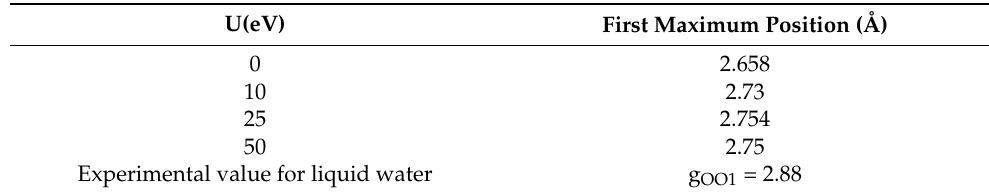
Table 10. First peak position in the radial distribution function of confined water.